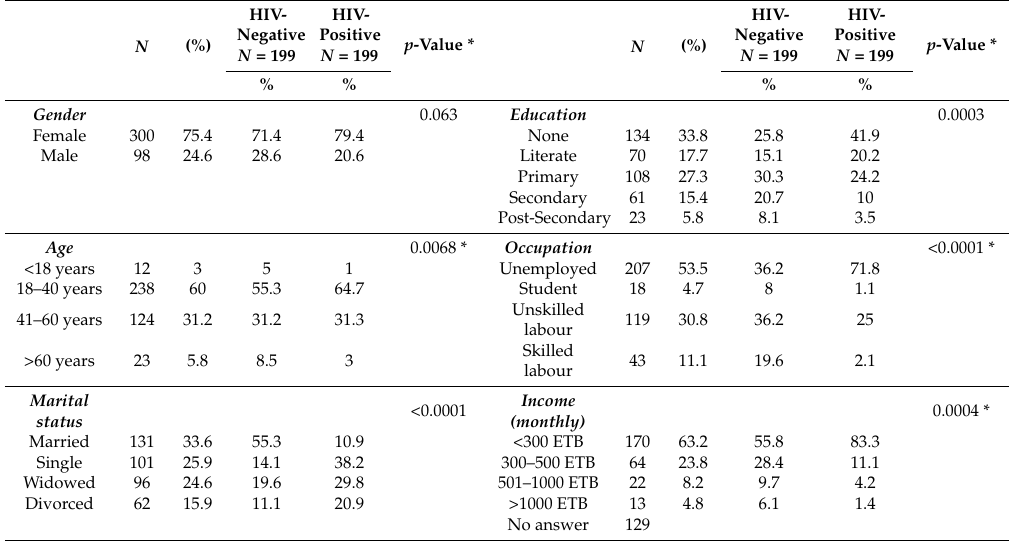
Table A1. Differences in socioeconomic characteristics among the HIV-negative and HIV-population of Wukro ( N =